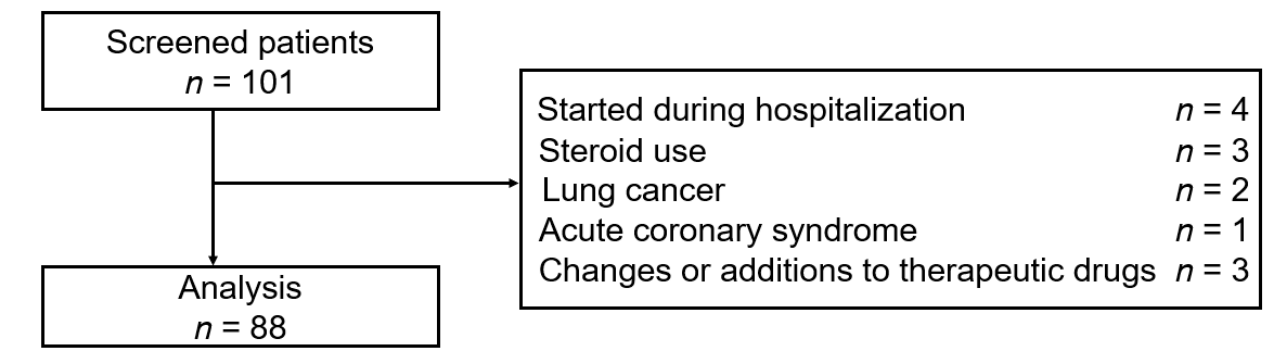
Figure 1. Flowchart of patient enrollment.